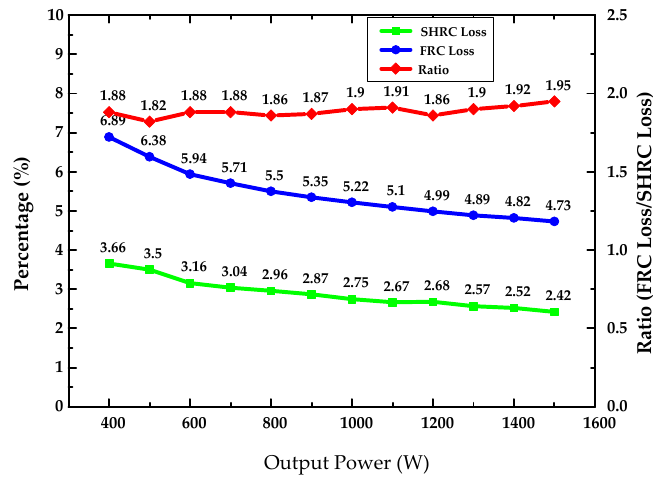
Figure 15. Power loss percentage of two converters.